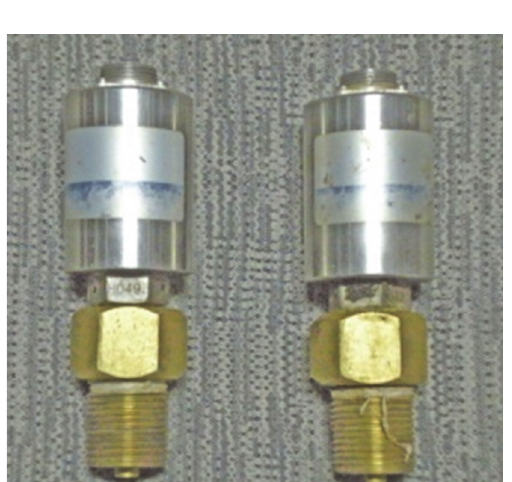
Figure 7: Pressure sensor.